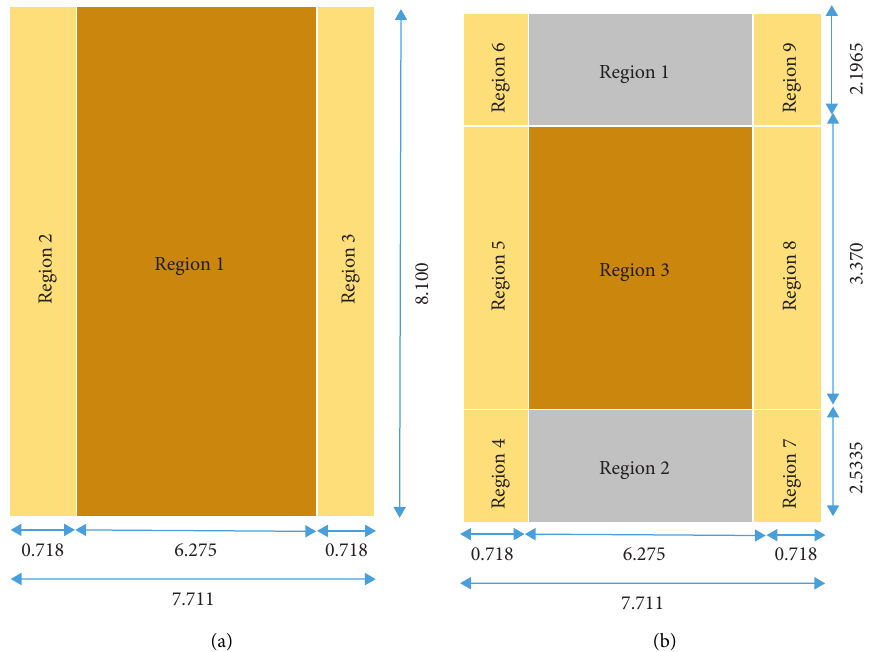
Figure 3: The planar model of fuel assembly. (a) Standard fuel element. (b) Control fuel element.